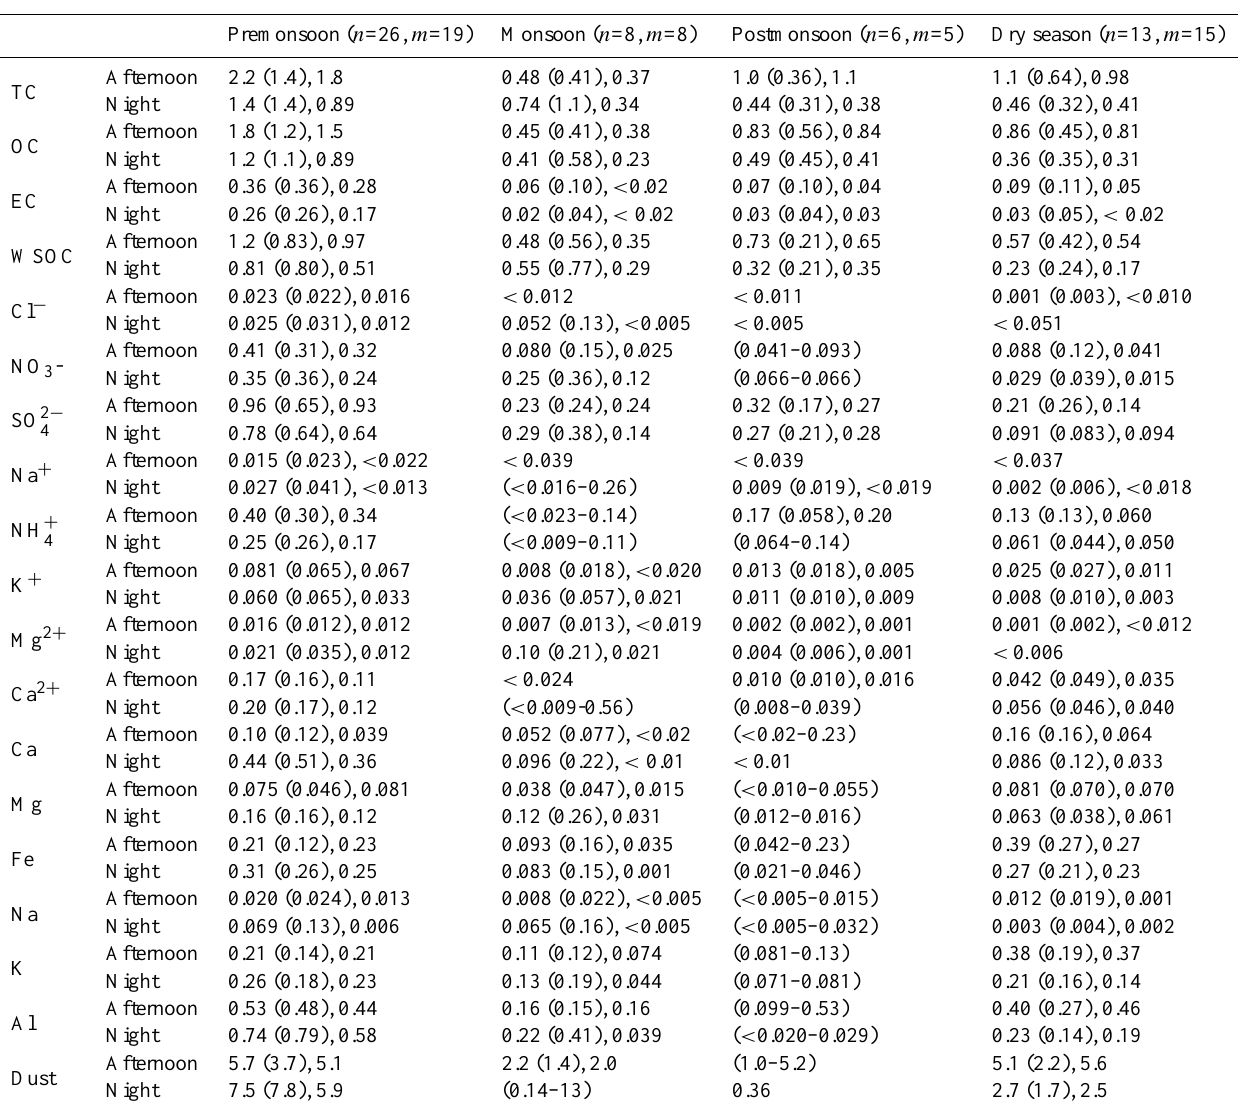
Table 1. Concentrations (µg/m 3 ) of the chemical species determined on PM 10 samples. Statistics are provided for the different seasons and for afternoon and night-time samples, and refer to all the samples collected between April 2006 and May 2008. The number of daytime and night-time samples analyzed in each period of the year are indicated by “ n ” and “ m ”, respectively. Data are reported in the format: average (standard deviation), median. However, for the sets including ≤ 4 samples, only the range of variation is given: (min–max). Notice that the concentrations were calculated using actual measured sampled air volumes. To obtain the concentrations in standard conditions, the values must be multiplied by a factor of